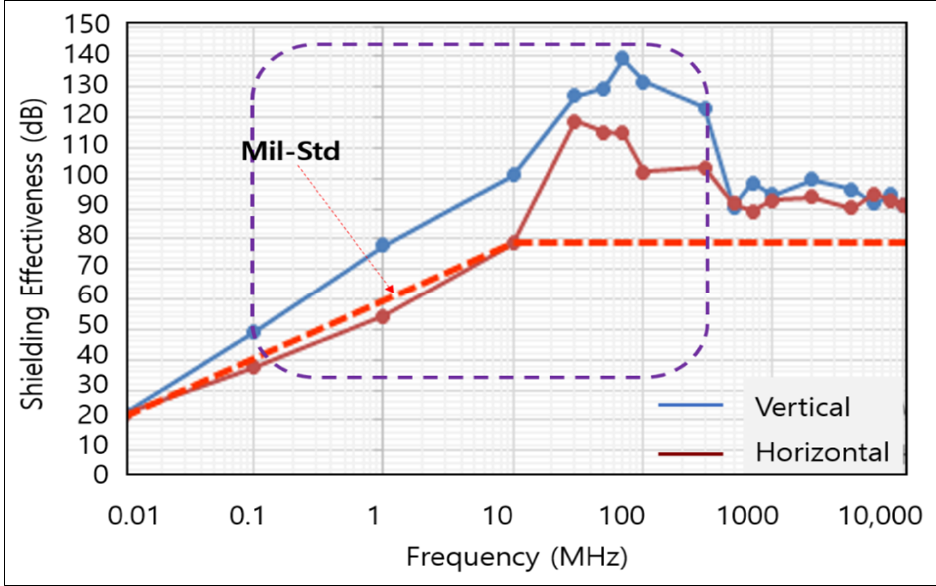
Figure 7. Shielding effectiveness of specimen #4 (W = 100).